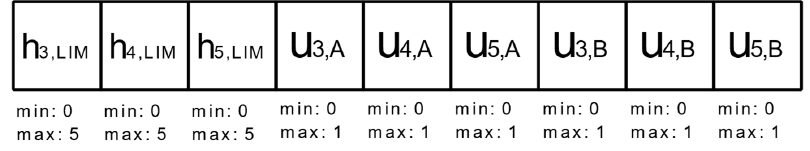
Figure 14. Strategy #3 chromosomal structure.